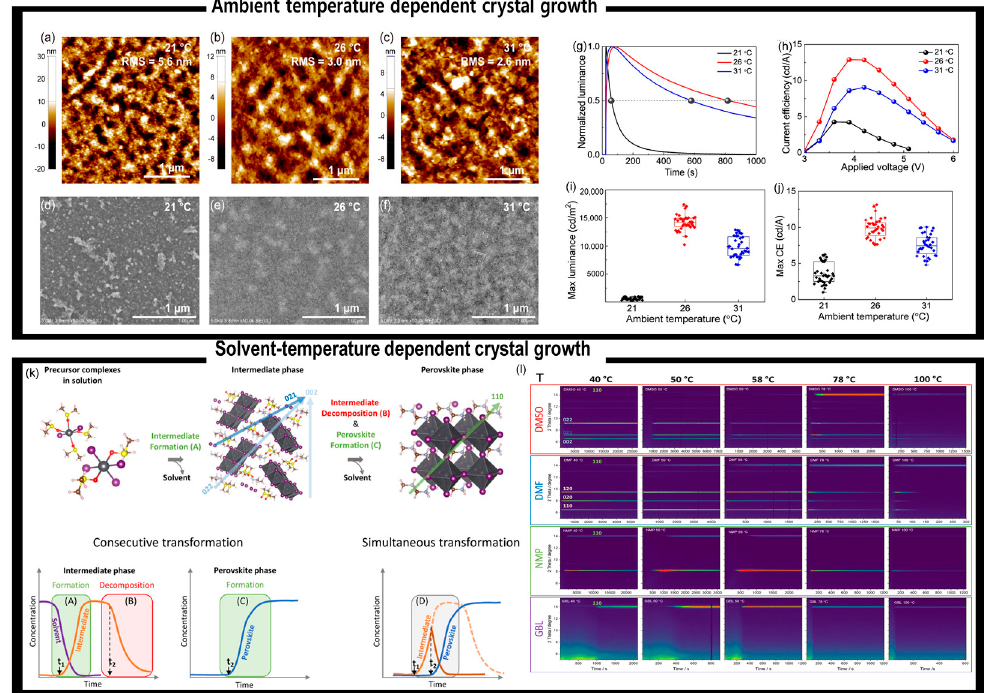
Figure 10. Temperature − dependent crystal growth. Temperature ‐ dependent crystal growth: AFM (top) and SEM images (bottom) (scale bar is 1 μ m) of the (PEA) 2 MAn–1Pb n Br 3n+1 layered perovskite films spin ‐ coated at an ambient temperature of ( a , d ) 21 °C, ( b , e ) 26 °C, and ( c , f ) 31 °C and ( g – j ) device performance for of perovskite films with different ambient temperatures [153]. ( k ) Schematic illustration of different processes, from perovskite crystal growth to formation of perovskite film (top) and consecutive and simultaneous transformation represented via kinetic curve (bottom). ( l ) Two − dimensional contour plots of GIWAXS detector frames in relation to time frame during crystallization of MAPbI 3 from DMSO, DMF, NMP, and GBL at different temperatures [154]. Reprinted with permission.